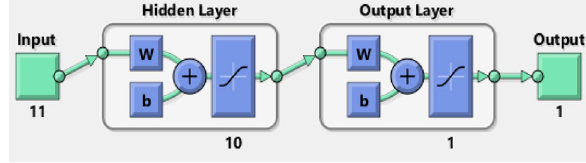
Fig. 1 ANN of 11–10–1 structure used for the prediction of MB removal efficiency by